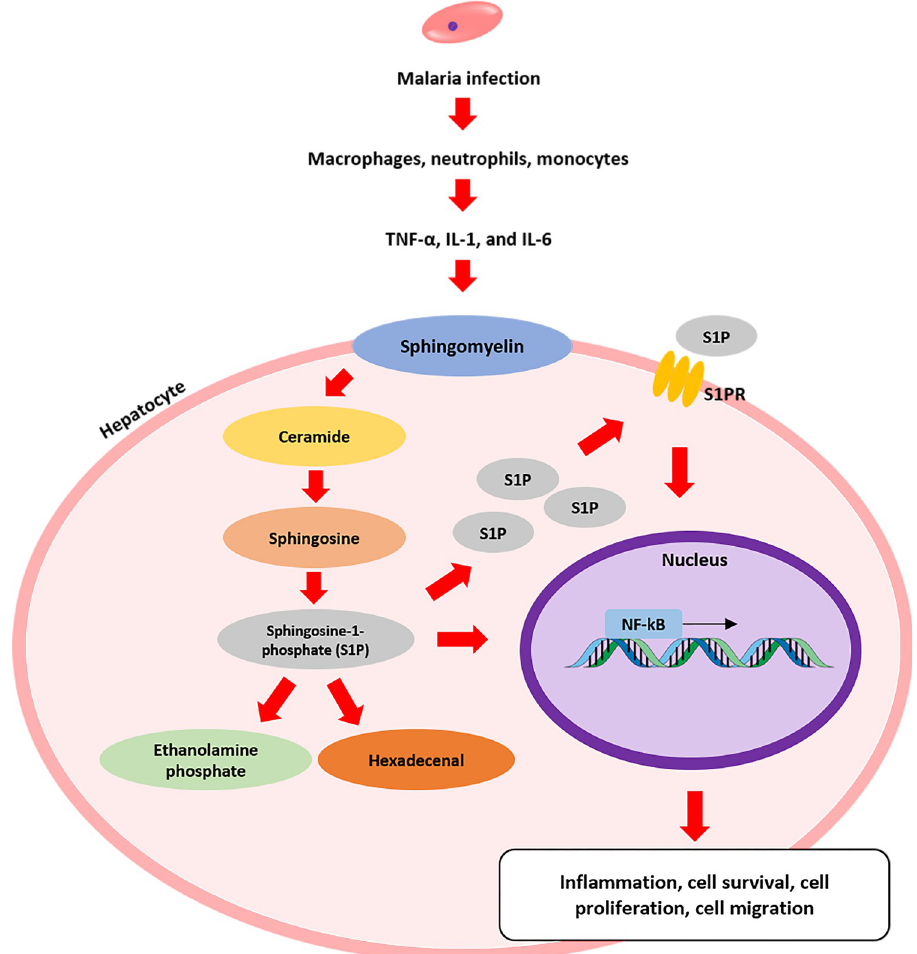
Fig 4. A schematic illustration of SphK/S1PR signaling during malaria infection. Plasmodium parasite-infected red blood cells induce the accumulation of macrophages, neutrophils, and monocytes, which further initiates the release of proinflammatory cytokines such as TNF- α , IL-1, and IL-6. These proinflammatory cytokines, especially TNF- α , bind to specific receptors on the cell membrane, which can activate sphingomyelin hydrolysis. Next, ceramide can be hydrolyzed to sphingosine by neutral ceramidase. Then, SphKs phosphorylate sphingosine to generate S1P, which directly induces NF- κ B activation and translocates to the extracellular space, where it can bind S1PRs and stimulate intracellular downstream signaling, resulting in inflammation and cell survival, proliferation, and migration. In addition, S1P can be degraded into ethanolamine phosphate and hexadecenal; in particular, hexadecenal can stimulate further inflammation in the